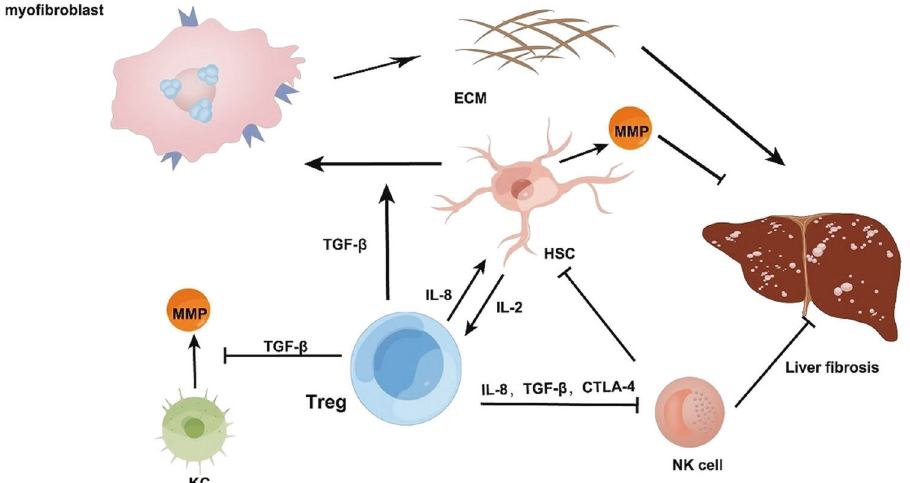
Fig. 1 The role of Treg in promoting fi brosis. Liver fi brosis is primarily induced by HSCs that promote TGF- β based production of myo fi broblasts that stimulate ECM-driven fi brogenesis. Tregs can also activate HSCs to promote fi brosis through the TGF- β pathway. Treg can induce HSCs via the expression of IL-8. Treg cells with CD4 + CD25 + Foxp3 + can be selectively expanded by HSCs in an IL-2 – dependent pattern. Tregs can directly suppress NK cells from degranulating in the role of IL-8, TGF- β 1, and CTLA-4 signalling pathways. Footnote: hepatic stellate cells (HSCs), transforming growth factor- β (TGF- β ), extracellular matrix (ECM), matrix metalloproteinase (MMP), regulatory cells (Treg), kupffer call (KC), interleukin-2 (IL-2), natural killer cell (NK cell), cytotoxic T-lymphocyte-associated protein 4